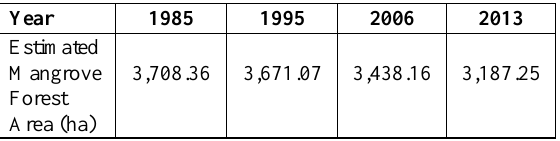
Table 7. Summary of status of mangrove forest area extent in Mafia Island from